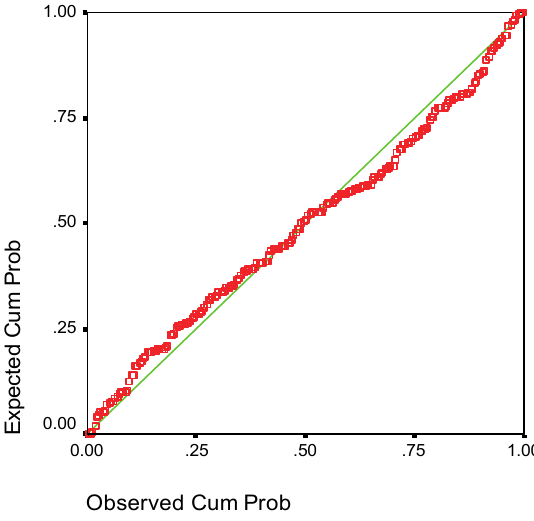
Fig. 4. Normal P-P Plot of Regression Standardized Residual for Knowledge Governance